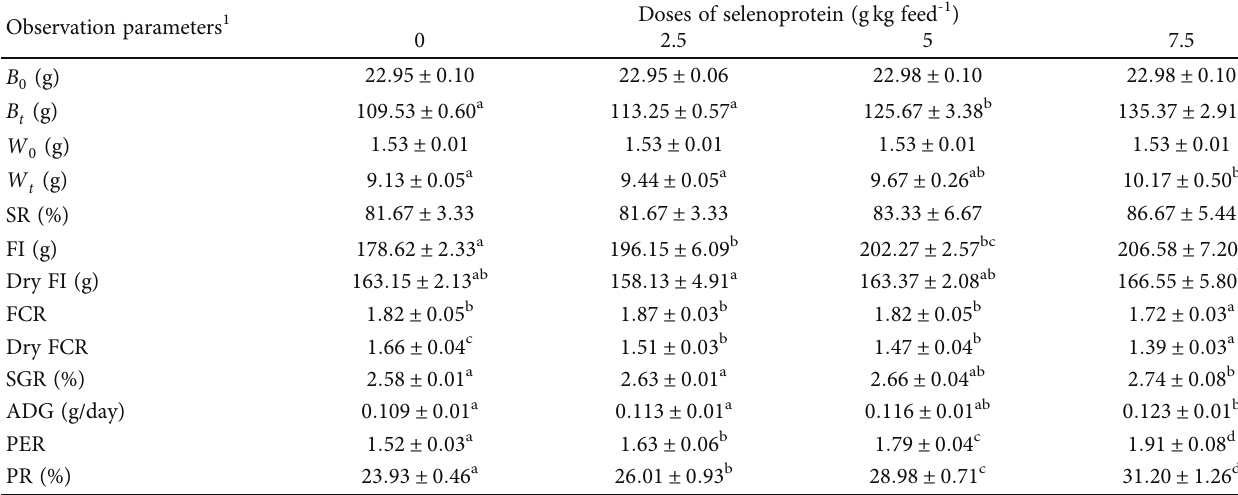
Table 3: Growth performance of whiteleg shrimp after being fed treatment for 70 days. Observation parameters 1